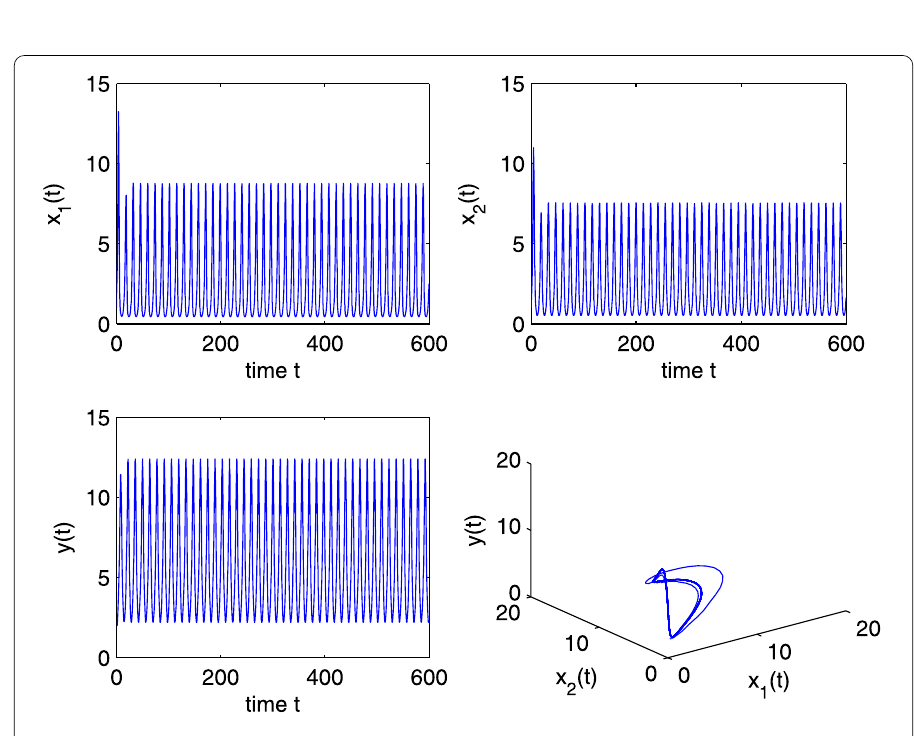
Figure 6 E ∗ undergoes a Hopf bifurcation for τ 1 = 2.4 > τ (cid:6) 10 = 2.3522 and τ (cid:6) 2 =